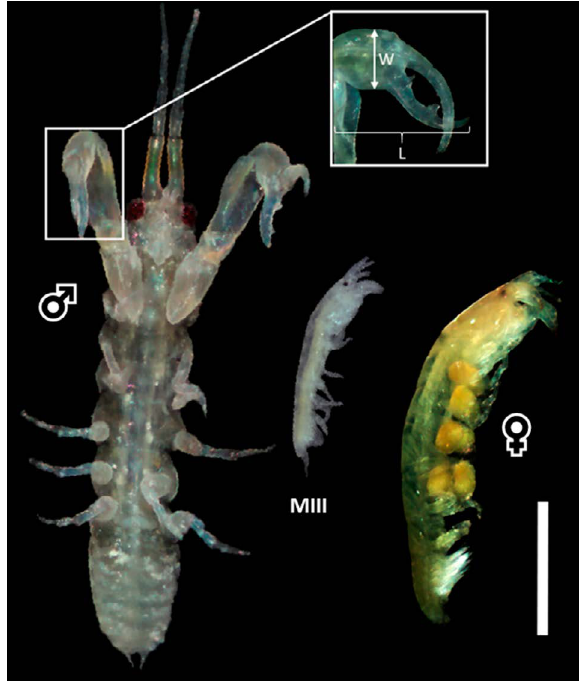
Fig. 1. – Fixed specimens of Chondrochelia dubia (Krøyer, 1842) collected in Paiva Beach, northeastern Brazil: adult male ( ♂ ) (left); manca III juvenile (centre) and ovigerous female ( ♀ ) (right). L, chela length; W, chela width. Scale bar, 1